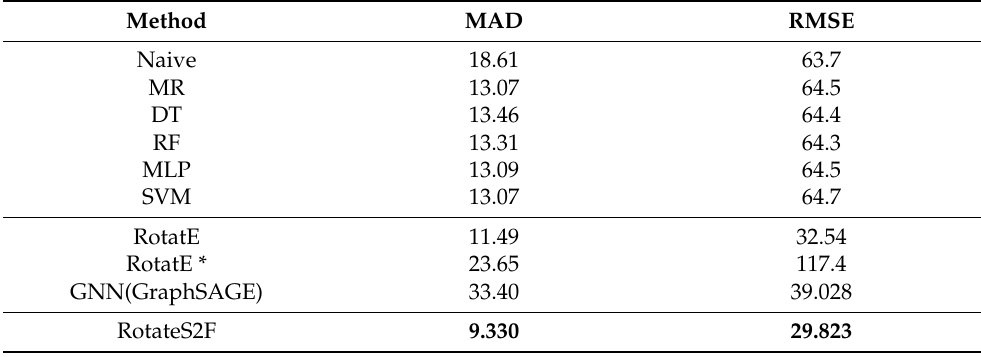
Table 6. The results of the MAD and RMSE ( bold : the best values). Method followed by “*” indicates that the knowledge graph has removed the FWI indicator attribute relation ( hasInfluence